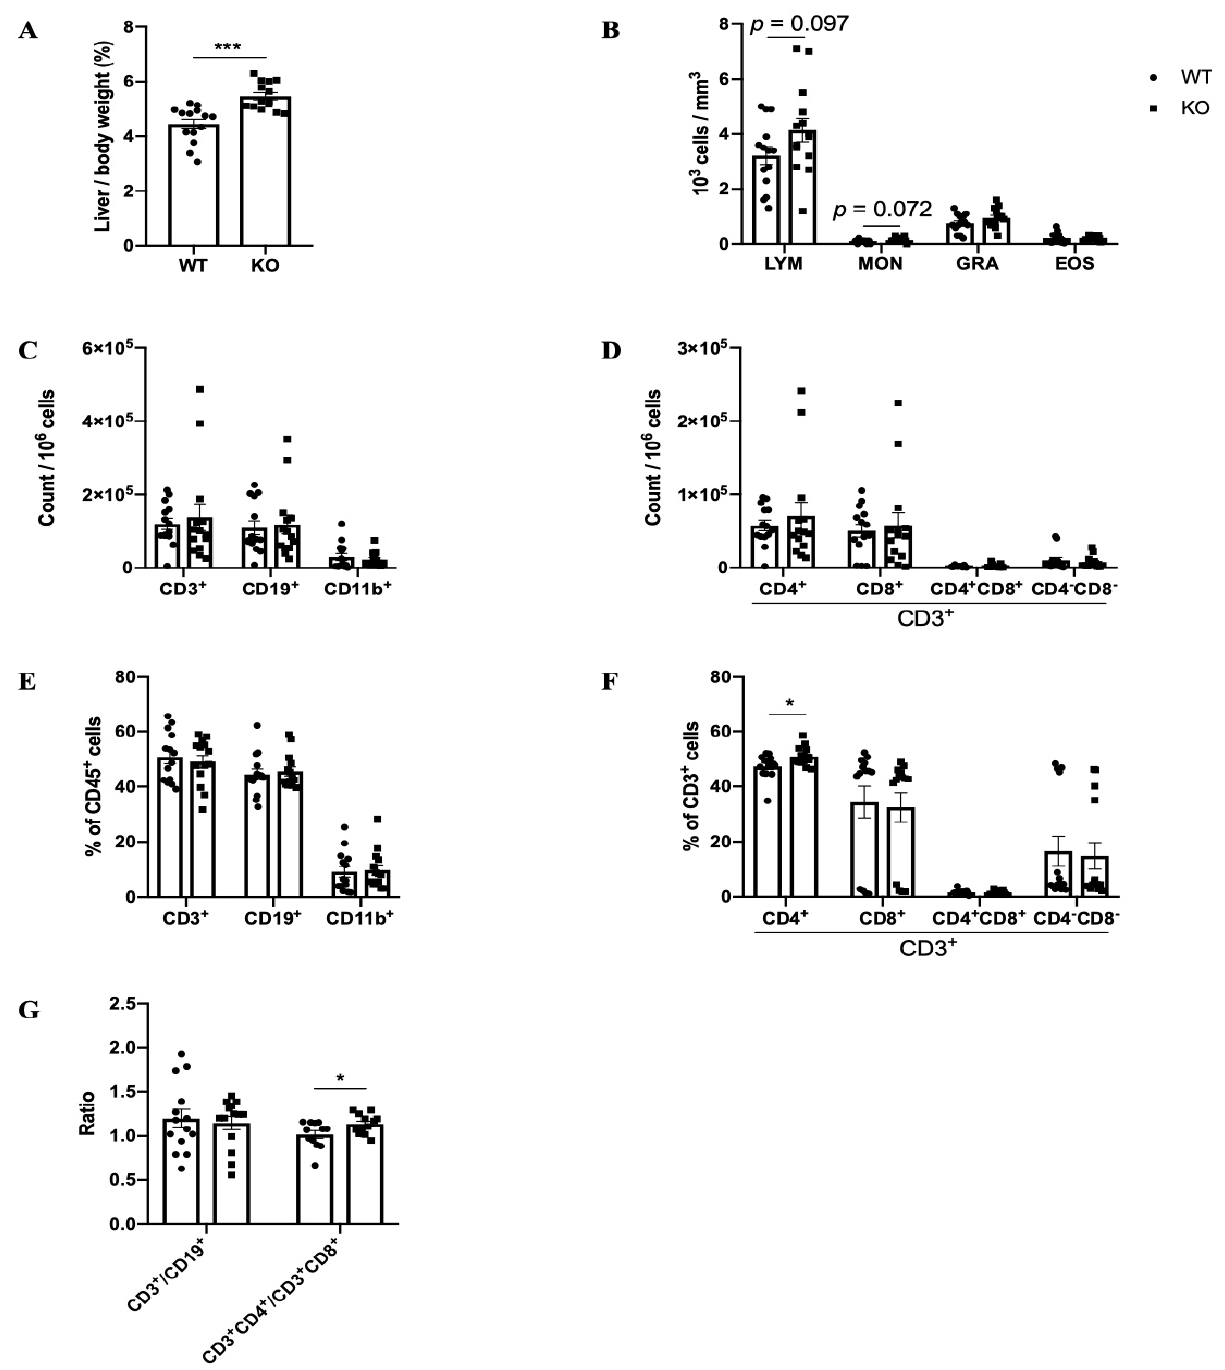
Figure 1. Phenotype of Pla1a − / − mice. Age- and sex-matched mice ( n = 14 per group, 7 males and 7 females) were euthanized to analyze the phenotype. ( A ) Liver-to-body weights ratio. ( B ) White blood cell counts in the blood. ( C , D ) Immune cell counts in the lymph node. ( E , F ) Percentage of immune cell populations in the lymph nodes quantified by flow cytometry. ( G ) Ratio of assigned cell populations. LYM, lymphocytes; MON, monocytes; GRA, granulocytes; EOS, eosinophils. *, p < 0.05; ***, p < 0.001; unnoted, p > 0.1.